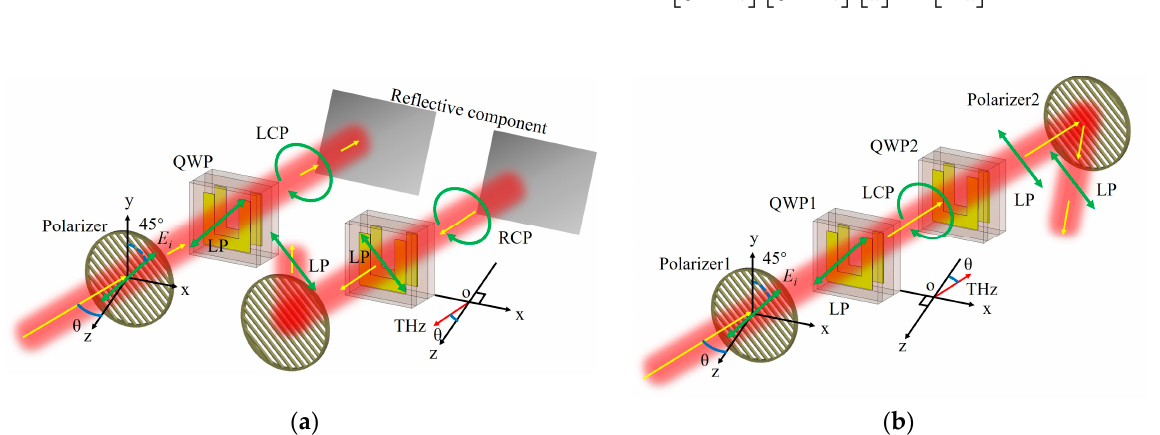
Figure 6. ( a ) Schematic diagram of the decomposition of the terahertz transmission optical path. On the left is the optical path of the terahertz wave entering the blocking device and reaching the reflective component, and on the right is the optical path of the terahertz wave being reflected by the reflective component and blocked by the polarizer. ( b ) Schematic diagram of the equivalent experimental optical path for measuring the blocking efficiency and insertion loss in this study.